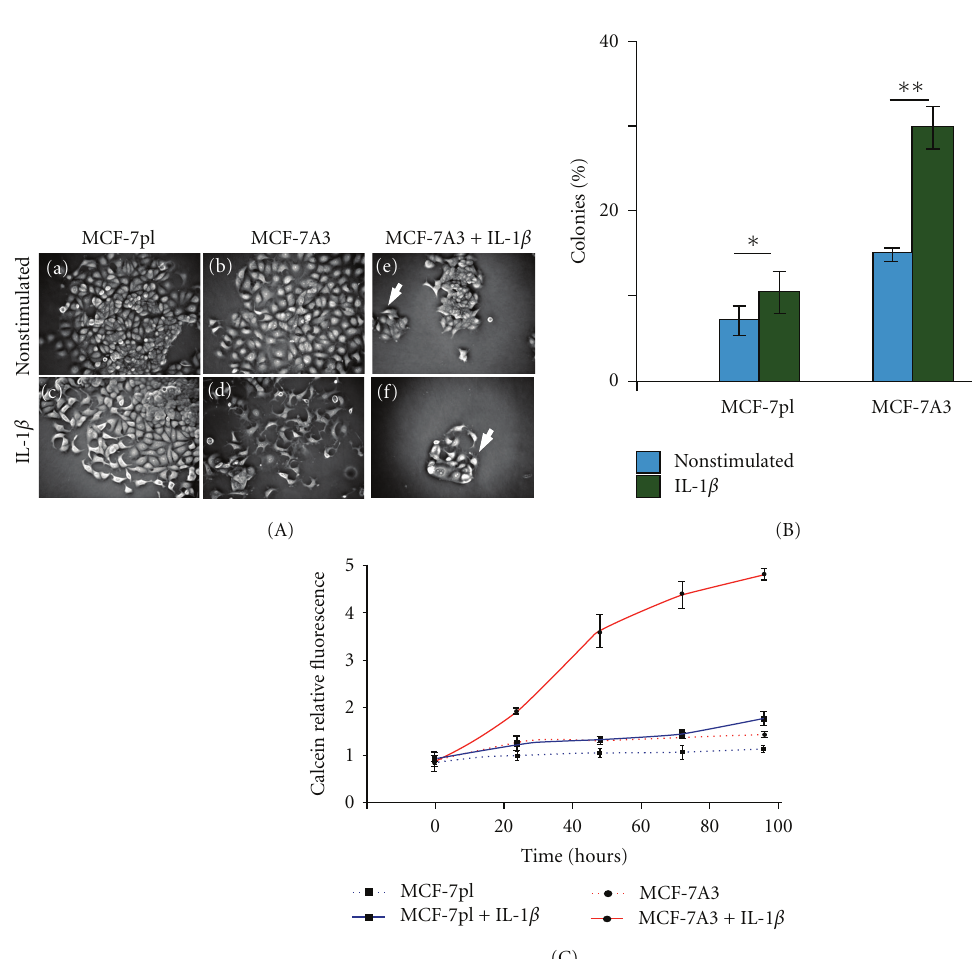
Figure 2: MCF-7A3 cells show increased sensitivity to IL-1 β demonstrated by their higher scattering, formation of colonies, and cell proliferation. Cells were seeded at very low density (200 cells per 100mm dish) and allowed to grow until well-defined individual colonies were formed. Cells were then stimulated with IL-1 β for 48 h. (A) Representative phase-contrast micrographs of colonies of MCF-7pl and MCF-7A3 cells show the di ff erence in cell scattering under IL-1 β stimulation. Arrowheads point to representative satellite colonies formed in MCF-7A3 cells after IL-1 β stimulus. (B) Quantification of the colonies formed by the two subpopulations in nonstimulated and stimulated conditions. Data are expressed as mean ± SD of triplicated experiments. ∗ P = 0 . 03; ∗∗ P = 0 . 005. Comparisons were made between results from nonstimulated and IL-1 β -stimulated conditions in the same cell subpopulation (Mann-Whitney U test). (C) Proliferation rate of MCF- 7 and MCF-7A3 cells expressed as increase of calcein-AM fluorescence. Cultures of both cell types were stimulated with IL-1 β as previously indicated. To determine proliferation rate, calcein-AM was added to cultures at 0, 24, 48, 72, and 96h for 2h. Calcein fluorescence emitted only by live cells was measured at 485nm for excitation and 520 nm for emission. Values are presented as relative fluorescence related to time 0h and it is the mean ± SD of three independent